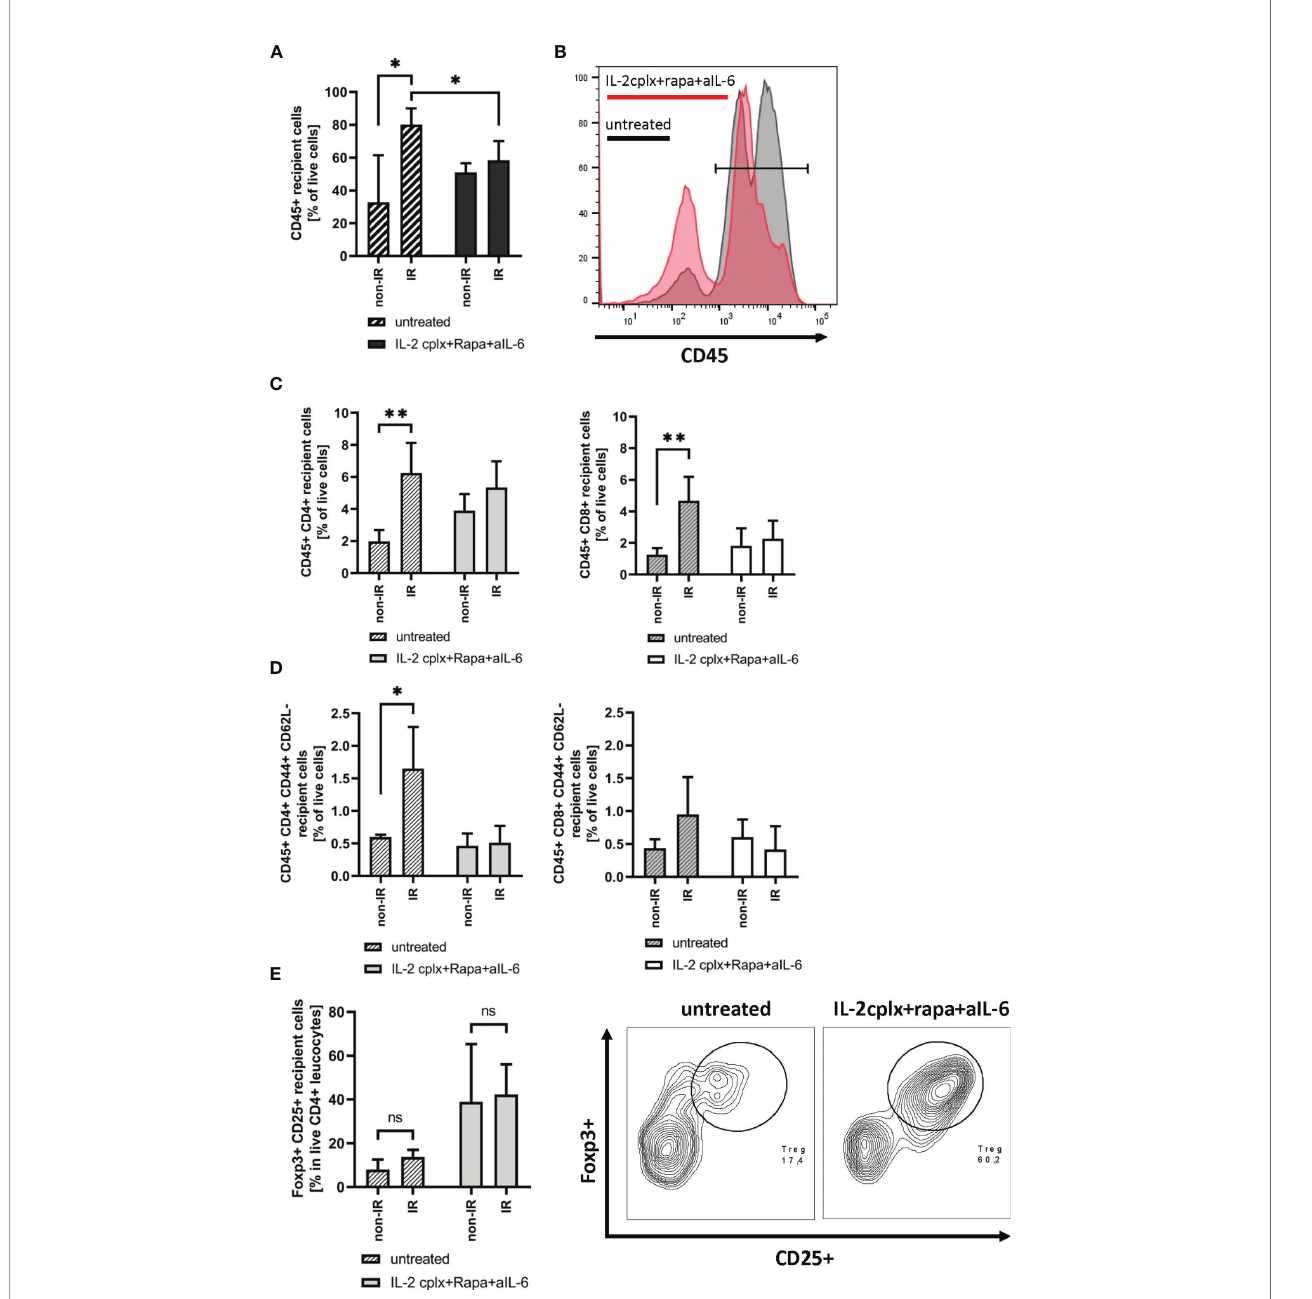
FIGURE 2 | Analysis of graft in fi ltrating leucocytes (recipient) 6 days post transplantation. (A) Frequency of CD45+ graft in fi ltrating leucocytes within skin grafts that were irradiated (IR) vs . non-irradiated (non-IR) before transplantation on mice receiving IL-2 complexes in combination with rapamycin and a short course of anti-IL-6 (IR: n = 5; non-IR: n = 6) or left untreated (IR: n = 5; non-IR: n = 5). (B) Representative histogram showing frequency of CD45+ graft in fi ltrating leucocytes in previously irradiated skin allografts. Results for recipients treated with IL-2cplx protocol are indicated in red, untreated are shown in grey. (C) Frequency of CD4+ (left) and CD8+ T cells (right) in fi ltrating the graft d6 post transplantation. (D) Frequency of CD4+ (left) and CD8+ (right) effector memory T cells (CD44+ CD62L-) found in skin allografts day 6 post transplantation. (E) Proportion of regulatory T cells (CD45+ CD4+ Foxp3+ CD25+) in the CD45+ CD4+ T cell population found within transplanted skin allografts day 6 after transplantation (left). Representative contour plot for regulatory T cell frequency within CD45+ CD4+ graft in fi ltrating cells (data from IR skin allograft transplanted mice; right). Analysis (A – E) was performed using fl ow cytometry and mean percentages of two independent experiments of untreated (IR: n = 5; non-IR: n = 5) and IL-2cplx protocol treated (IR: n = 5; non-IR: n = 6) recipients transplanted with irradiated or non-irradiated skin grafts are shown. Error bars indicate SD. (ns, not signi fi cant P > 0.05; *P < 0.05; **P < 0.01; two-tailed t test with unequal